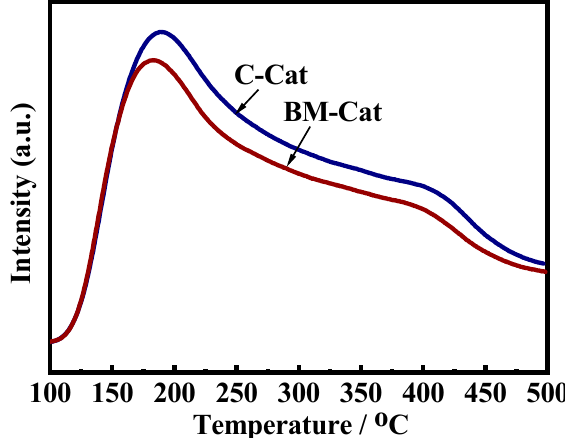
Figure 4. NH 3 -TPD profiles of C-Cat and BM-Cat.